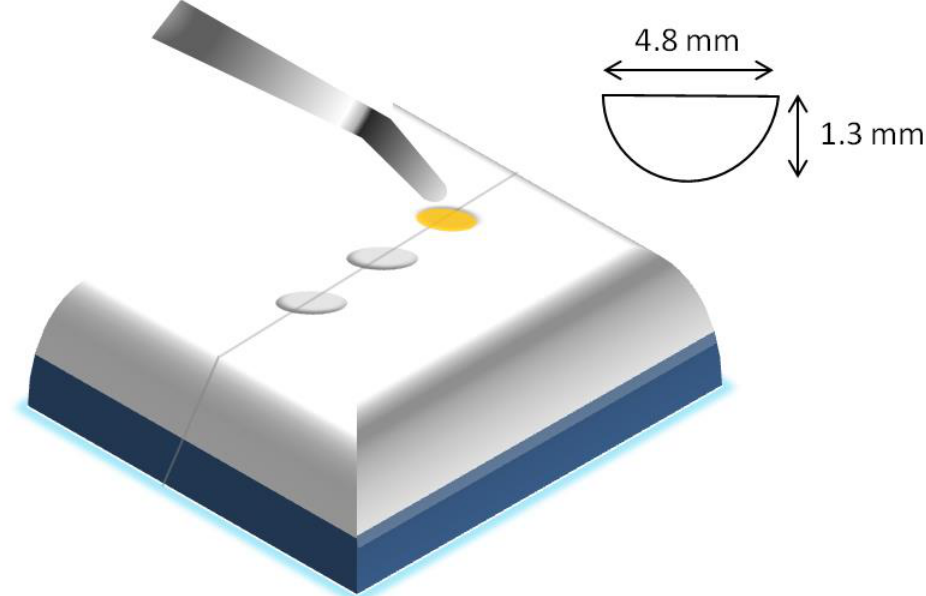
Figure 2. Scheme of polytetrafluoroethylene die used in the present study. The shape allowed the dental resin composite placement with standardized volume.